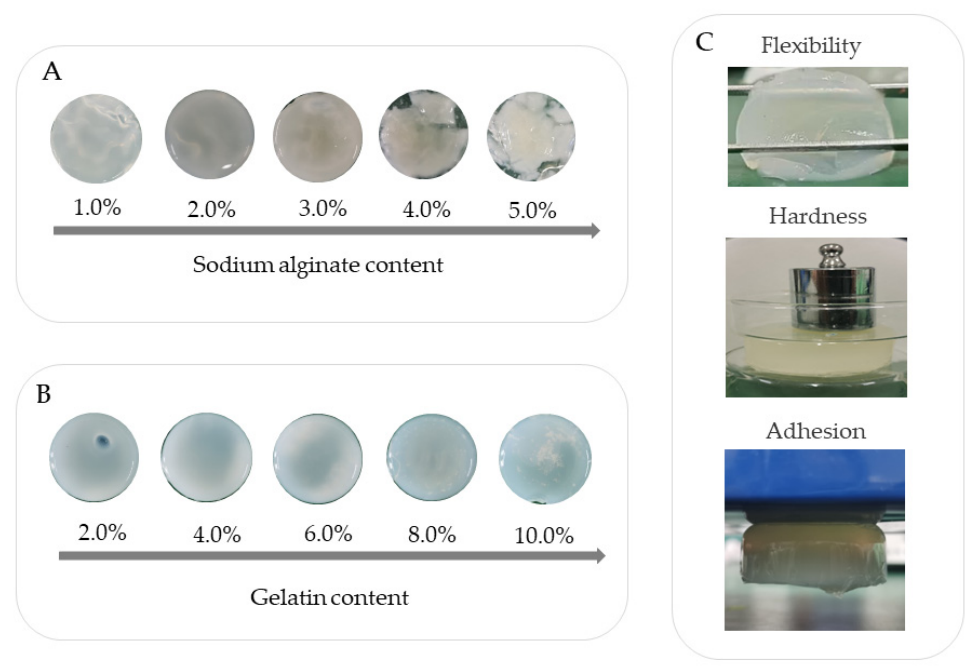
Figure 2. Properties of Gel–Alg hydrogel. ( A ) Morphology of Gel–Alg hydrogel containing differ- ent concentrations of sodium alginate. ( B ) Morphology of Gel–Alg hydrogel containing different concentrations of gelatin. ( C ) Flexibility, stiffness and adhesion performance of Gel–Alg hydrogel.